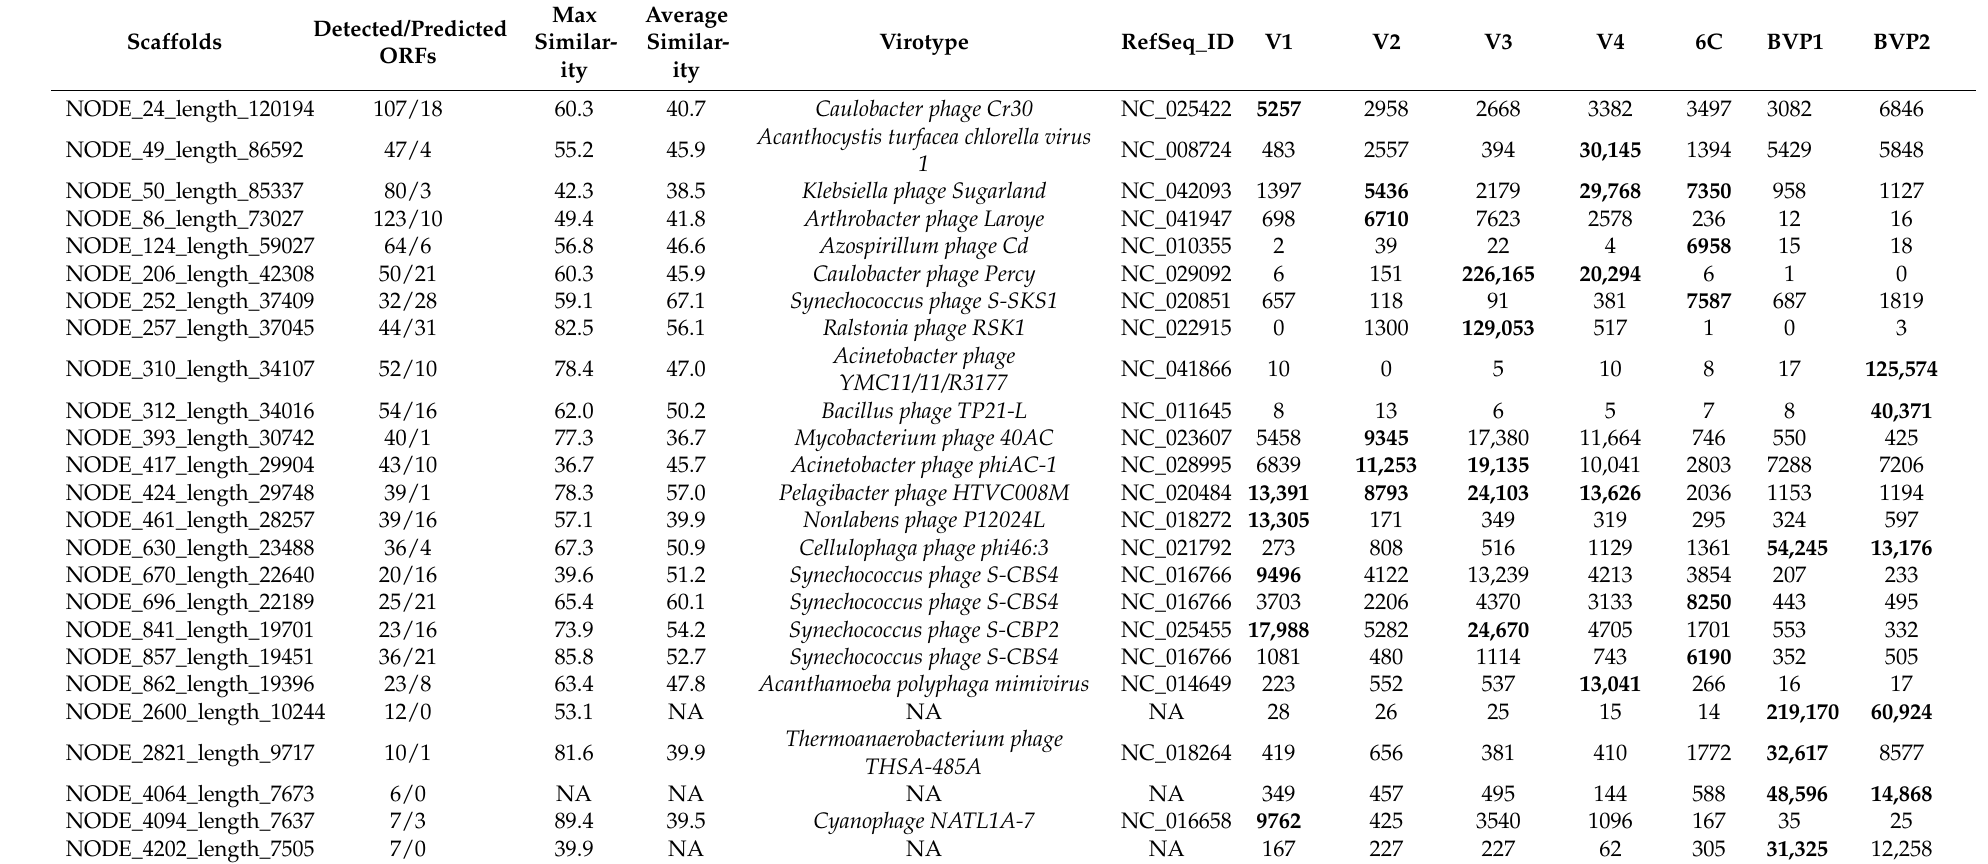
Table 5. The viral scaffolds mostly represented in the Baikal samples (including the published ones [27,28]); the maximum and average similarity (in %) of predicted viral proteins with the NCBI RefSeq viral proteome database and related virotypes (the five largest sets of reads corresponding to specific virotype in each sample are marked in bold).